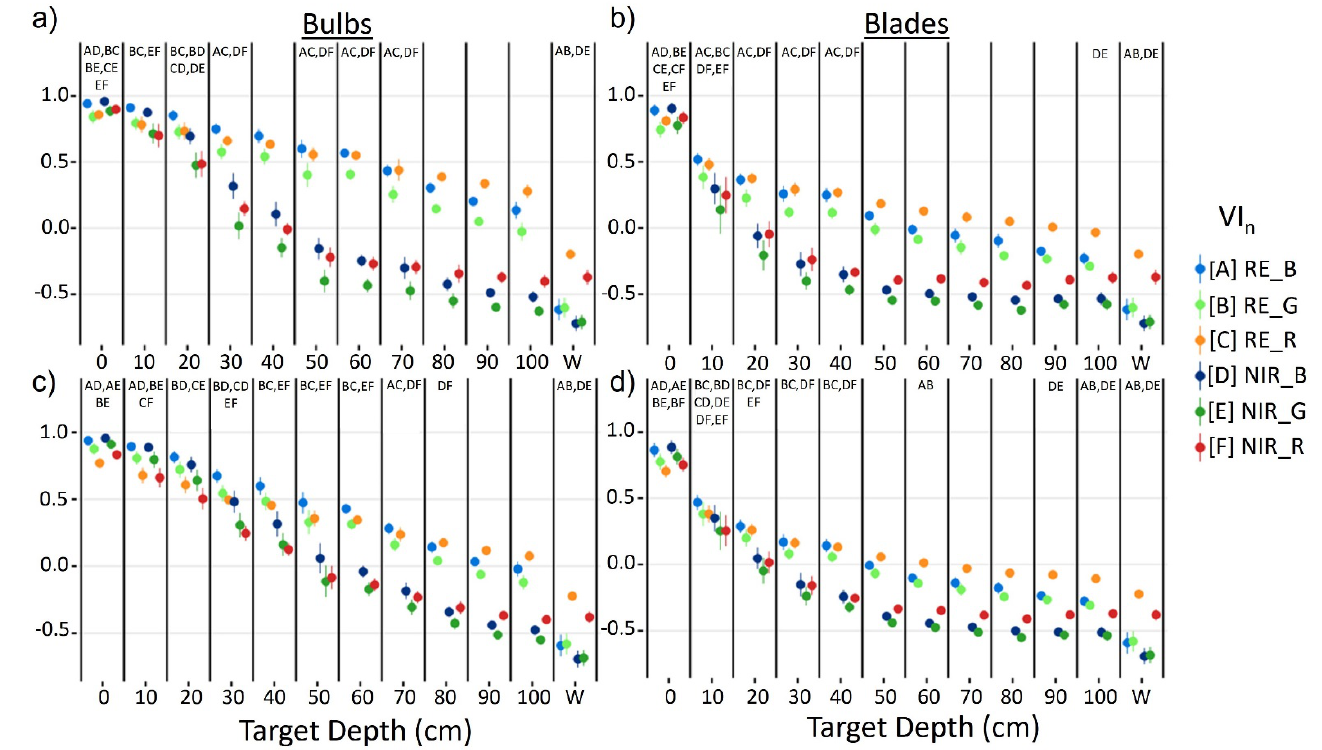
Figure 6. Mean +/ − sd of vegetation index (VI n ) values for Nereocystis bulbs ( a , c ) and blades ( b , d ), submerged from the surface to 100 cm and water; derived from simulated Micasense RedEdge-MX (MSRE; a , b ) and WorldView-3 (WV3; c , d ) bandwidths. Paired letters above each column represent no significant differences ( p ≥ 0.05) between mean index values at that depth.